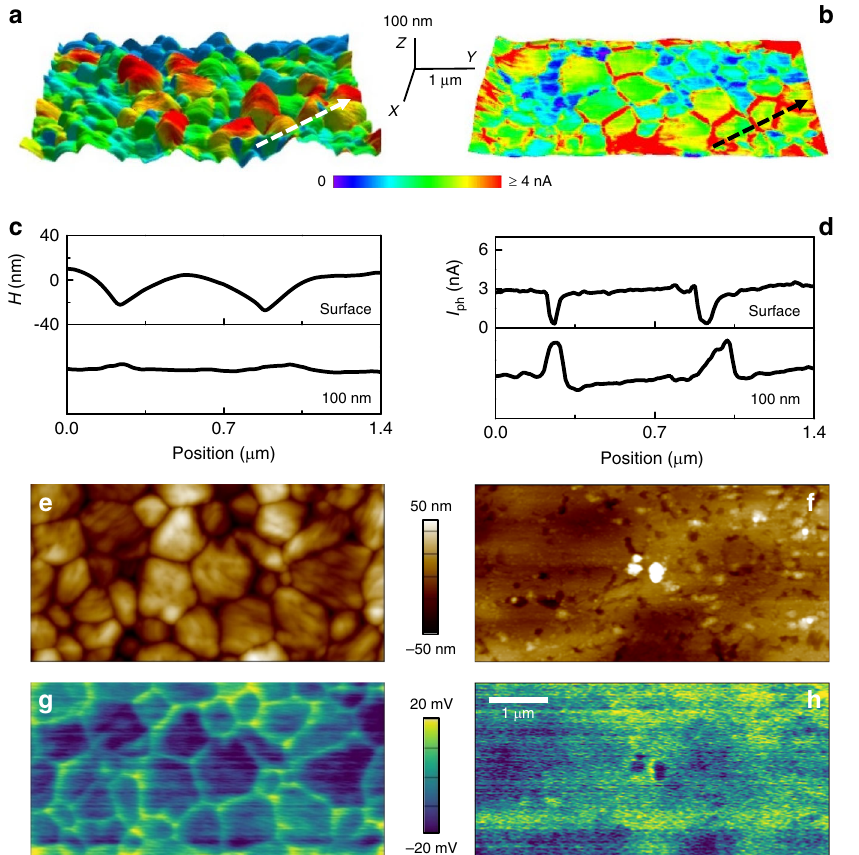
Fig. 2 Nanomachining of MAPbI 3 perovskite thin fi lm using T-AFM. a – b 3D perspective of MAPbI 3 thin- fi lm topography overlaid by photocurrent color contrast for a single 3 µ m × 6 µ m region, both at the as-received top surface ( a ) and after nanomachining 100 nm into the fi lm ( b ). c Topography line-scans indicated by arrows in ( a , b ). d The simultaneously acquired corresponding photocurrent line scans which evidence relative signal inversion beneath the as- received surface. e – f Similar topography images pre- and post-nanomachining for the same sample, with matching g , h surface potential maps also indicating dramatic contrast variations at and beneath the surface. Images ( e ) – ( g ) share the same scale bar with ( h